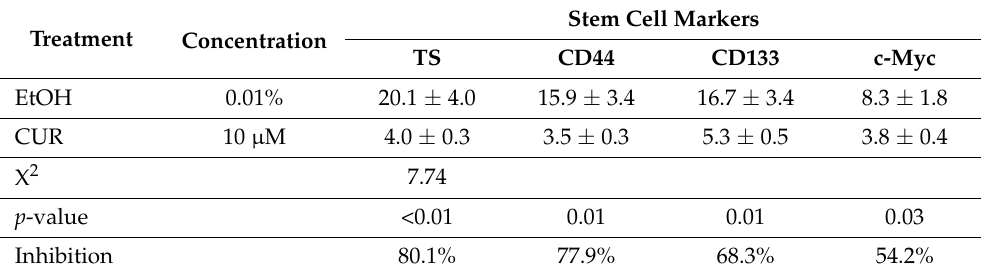
Table 7. Experimental modulation of stem cell markers in the Sulindac-resistant SUL-R colon cancer